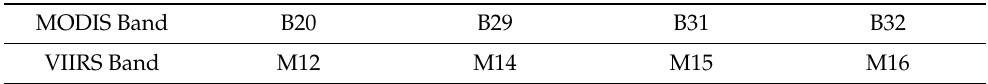
Table 4. Matching of thermal emissive bands between MODIS and VIIRS.